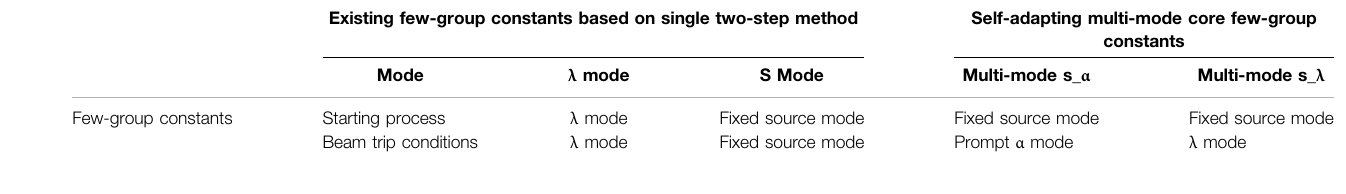
TABLE 5 | Few-group constants used in various